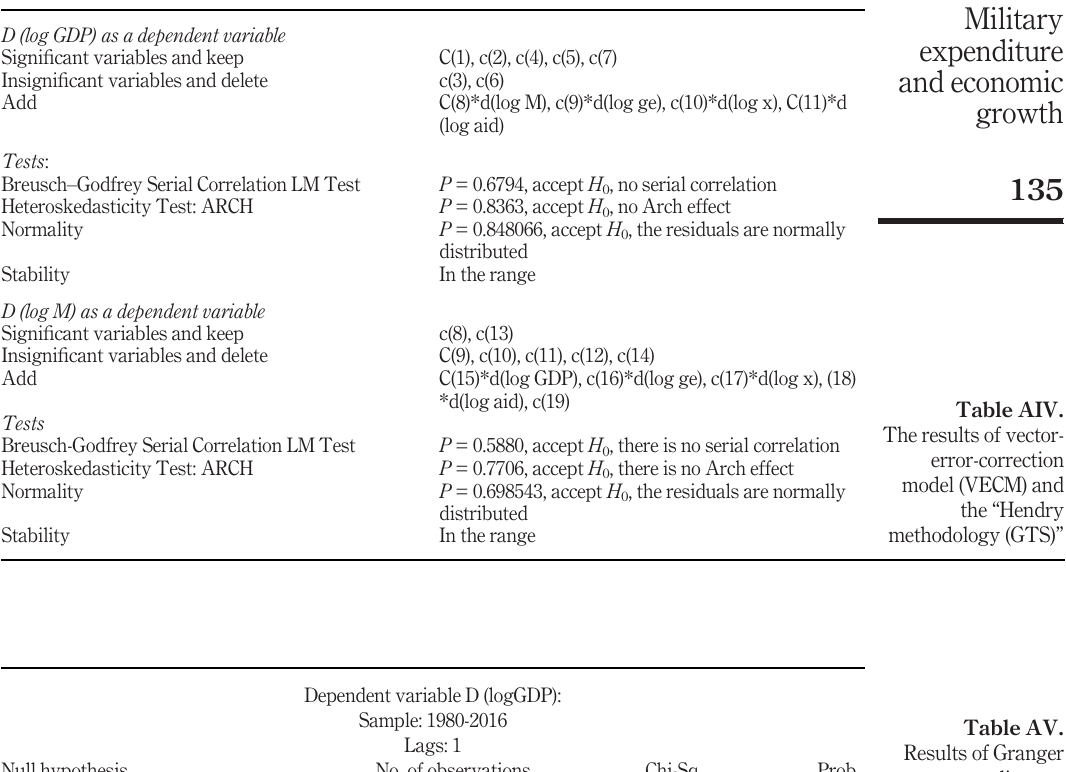
Table AV. Results of Granger